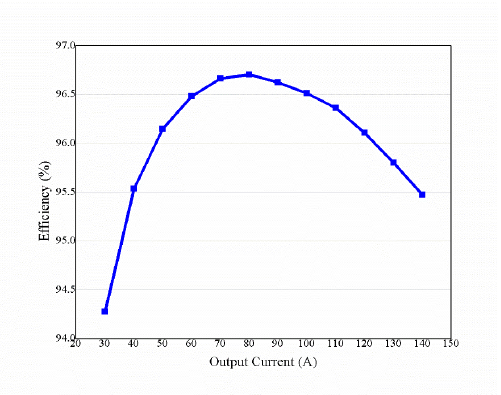
Figure 15. Efficiency curve for the phase-shifted full-bridge converter with an integrated transformer.